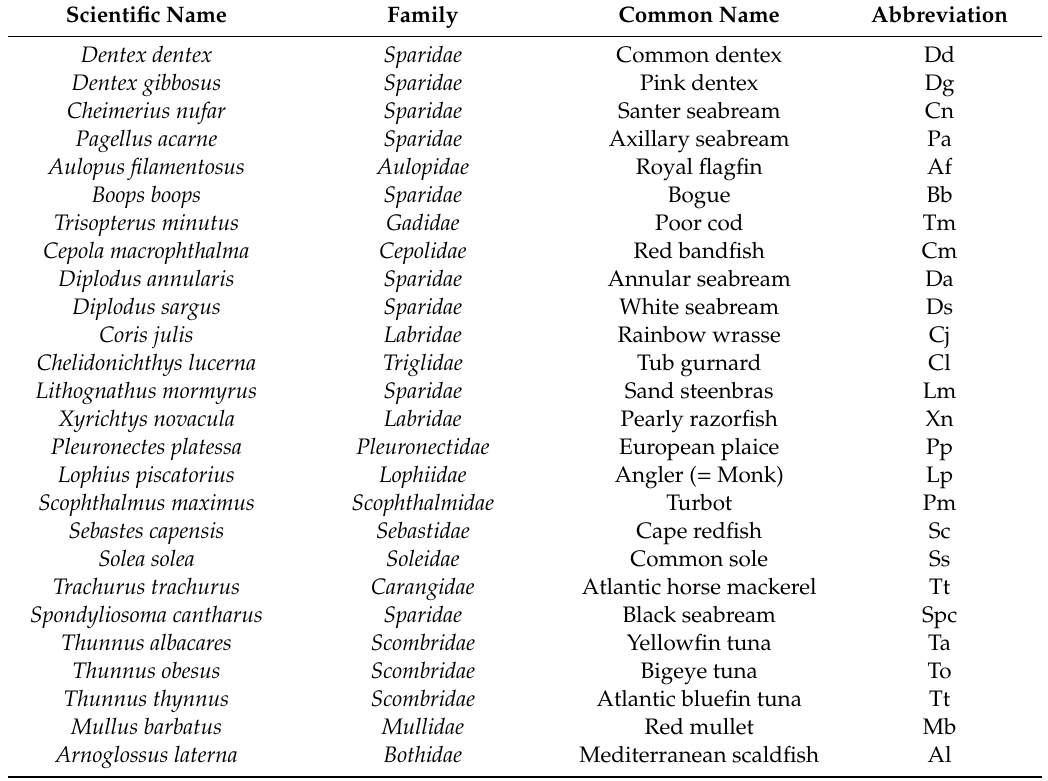
Table 2. Fish species other than P. erythrinus used in this study by end-point PCR and Real-Time qPCR. Common names are from ASFIS List of Species for Fishery Statistics Purposes (http: // www.fao.org / fishery / collection / asfis / en).